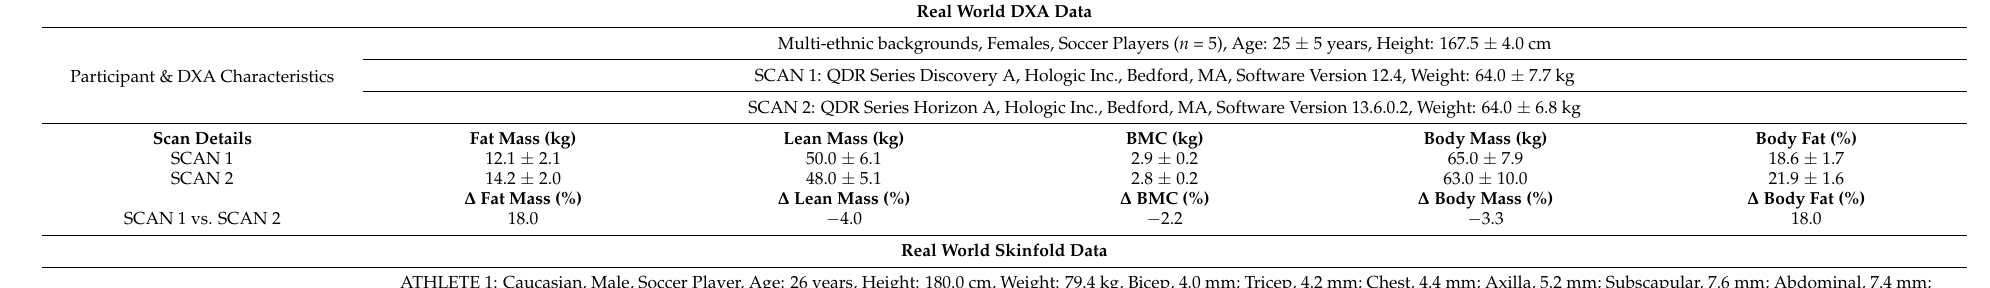
Table 2. Example of the differences observed in practice using real-world data derived from English Premier League and Women’s Super League soccer players. This includes using different DXA scanners made by the same company, on the same individuals, alongside an example of the effect of different predictive equations on collected skinfold